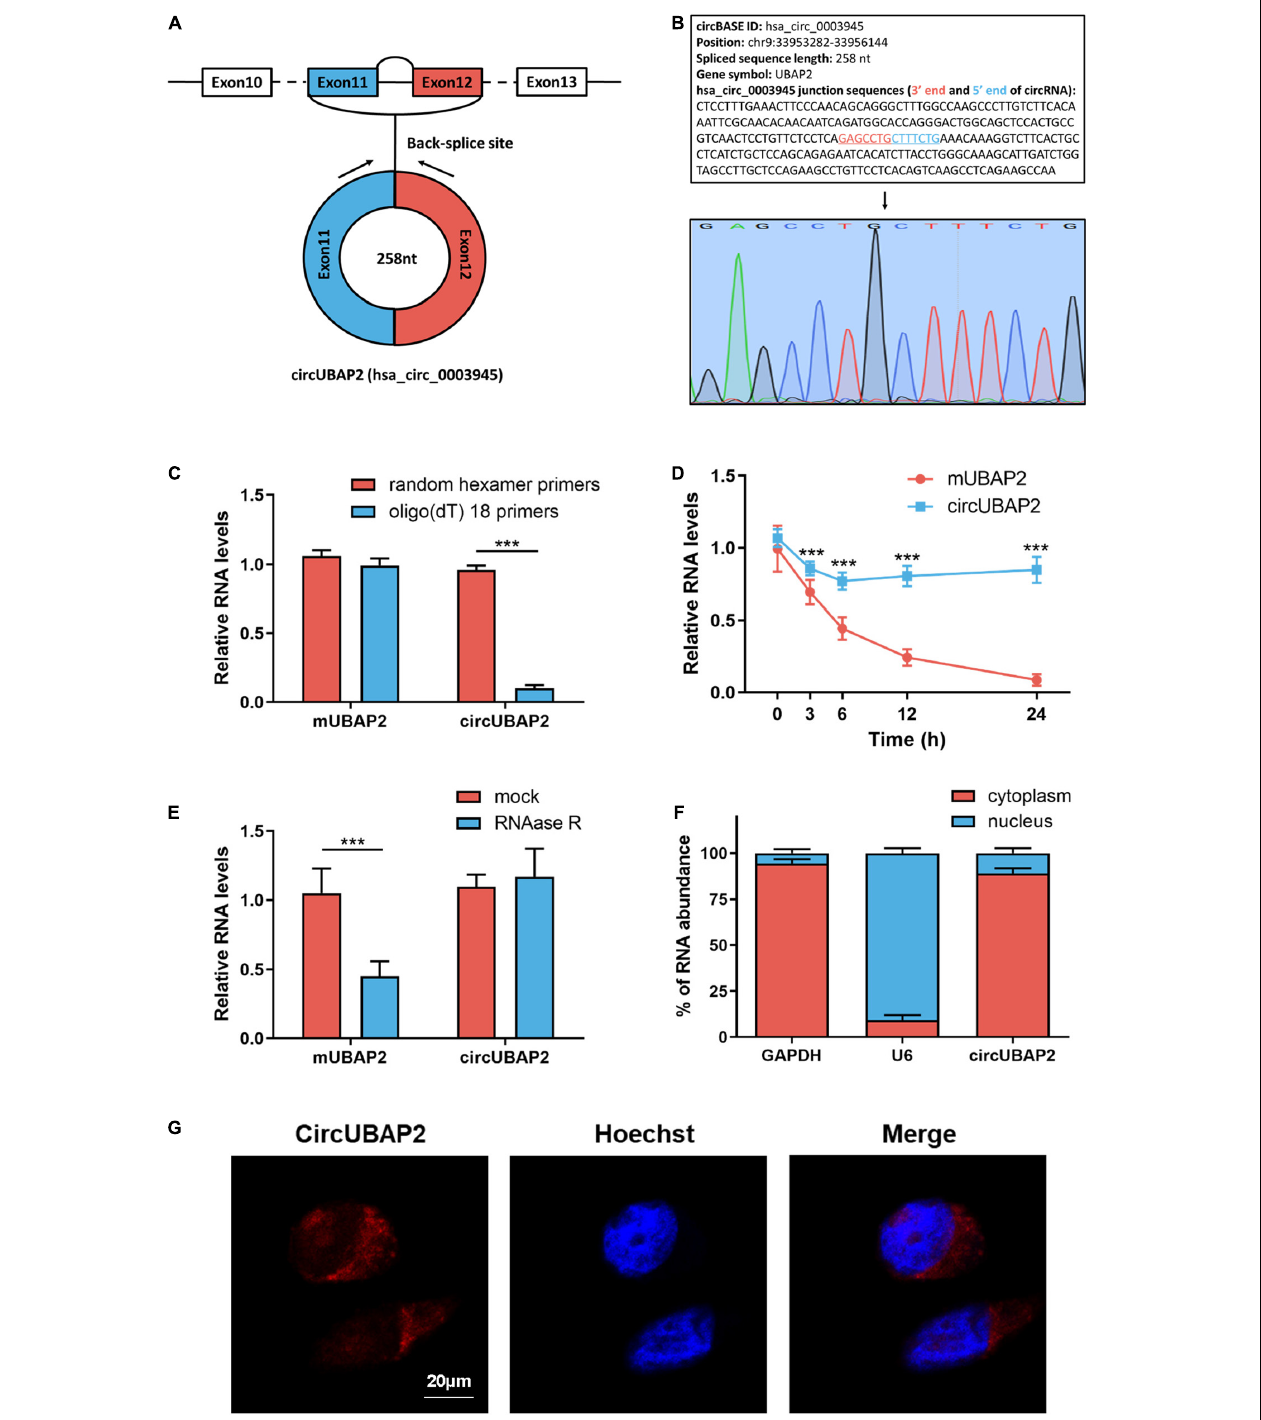
FIGURE 2 | CircRNA characterization of circUBAP2 in HCC. (A) The exonic information of circUBAP2 (circBase ID: hsa_circ_0003945) is illustrated as indicated. (B) The specific primers of circUBAP2 were validated by Sanger sequencing. The black arrow indicates the backsplice site. (C) Random hexamer or oligo (dT) 18 primers were utilized for reverse transcription assays. The relative RNA levels were examined by RT-qPCR and normalized to those generated using random hexamer primers. (D) The relative RNA levels were examined by RT-qPCR after treatment with actinomycin D at the indicated time points. (E) The relative RNA levels were examined by RT-qPCR after treatment with RNase R or mock in total RNAs. (F) The cellular distribution of circUBAP2 was analyzed by cellular RNA fractionation assays. GAPDH and U6 were used as cytoplasmic and nuclear positive controls, respectively. (G) The cellular distribution of circUBAP2 was analyzed by fluorescence in situ hybridization (FISH). Scale bar = 20 µ m. *** P < 0.001.